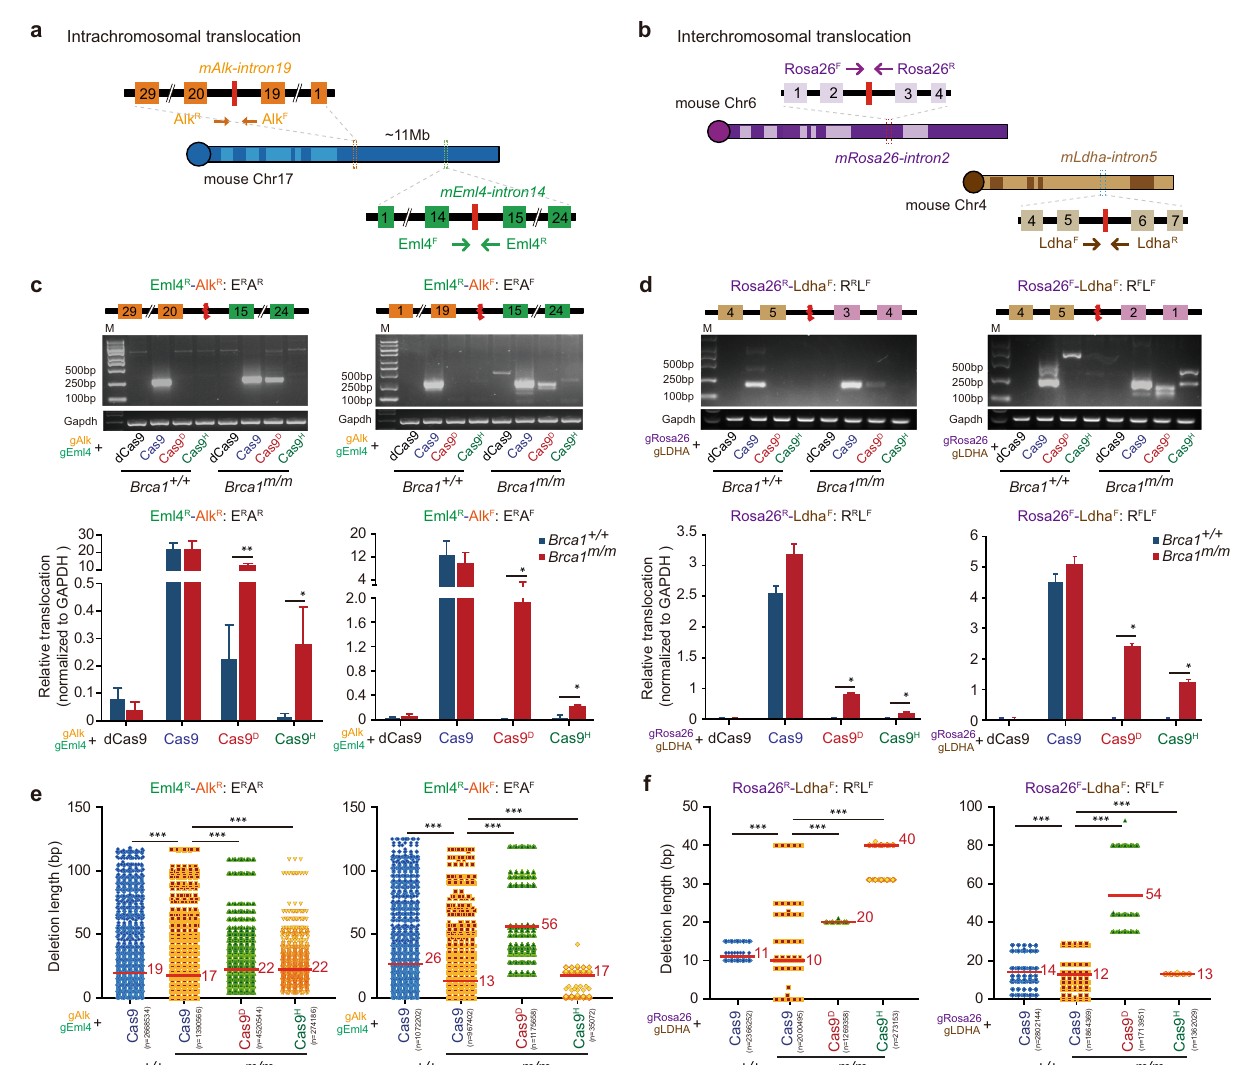
Fig. 4 | BRCA1 suppresses nick-induced translocation. a , b Schematic for inductionofintrachromosomaltranslocationsbetweenthe Alk and Eml4 loci( a )or interchromosomal translocations between the Rosa26 and Ldha loci ( b ) in mESC. RedlinesindicatetheCas9ornCas9targetsites fl ankedbyPCRprimersdenotedin an arrowed line for translocation detections. c , d PCR products and quanti fi cation of Eml4 – Alk translocations ( c ) and Rosa26 – Ldha translocations ( d ) in Brca1 +/+ and Brca1 m/m mESC transfected with dCas9, Cas9 or nCas9. Schematics of Eml4 – Alk translocations E R A R and E R A F ( c ) and Rosa26 – Ldha translocations R R L F and R F L F ( d ) are shown on top. PCR products of translocations and Gapdh as an internal PCR control (middle) weremixedin the ratio of 10:1 in volume for Illumina sequencing. Translocations were quanti fi ed as relative translocation levels, which are ratios of